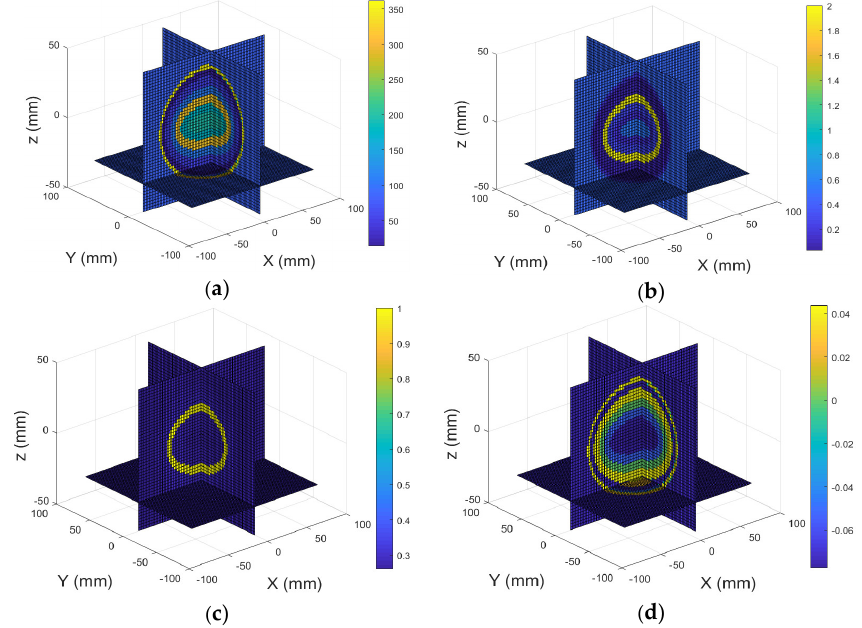
Figure 5. 3D view of the head model with no brain lesion: ( a ) Real part; ( b ) Imagery part; 3D reconstructed images of the head model with no brain lesion: ( c ) Real part; ( d ) Imagery part.